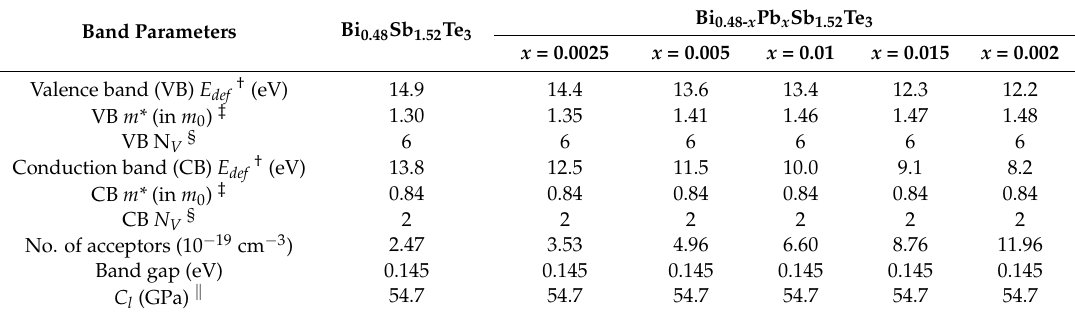
Table 1. Band parameters used to estimate the bipolar contribution to thermal conductivity, κ bp , of the Pb-doped samples using the two-band model.